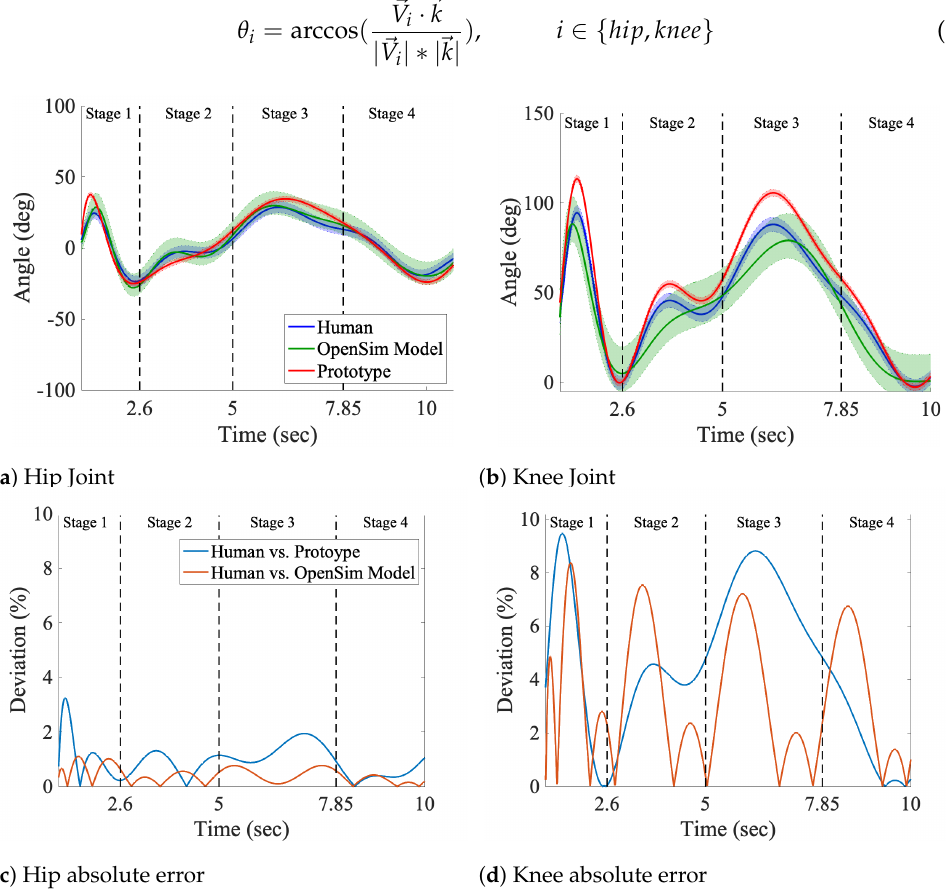
Figure 8. Simulated and measured angles of the hip ( a ) and knee ( b ) joints during the four stages of gait, and ( c , d ) the absolute errors, between angles across multiple trials (see Table 2). The shaded range represents the lower and upper limits of motion through simulated trials with the chosen configuration in a solid